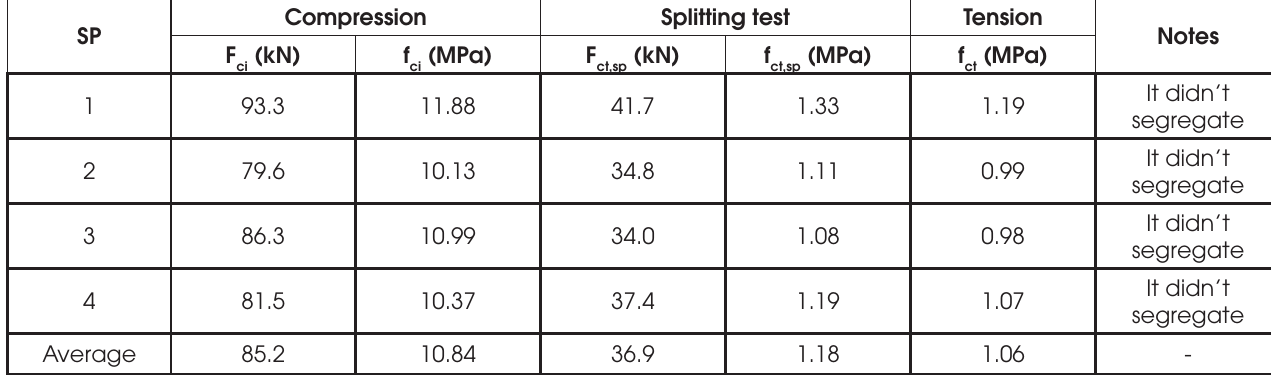
Description of 1 st batch from SLCEB